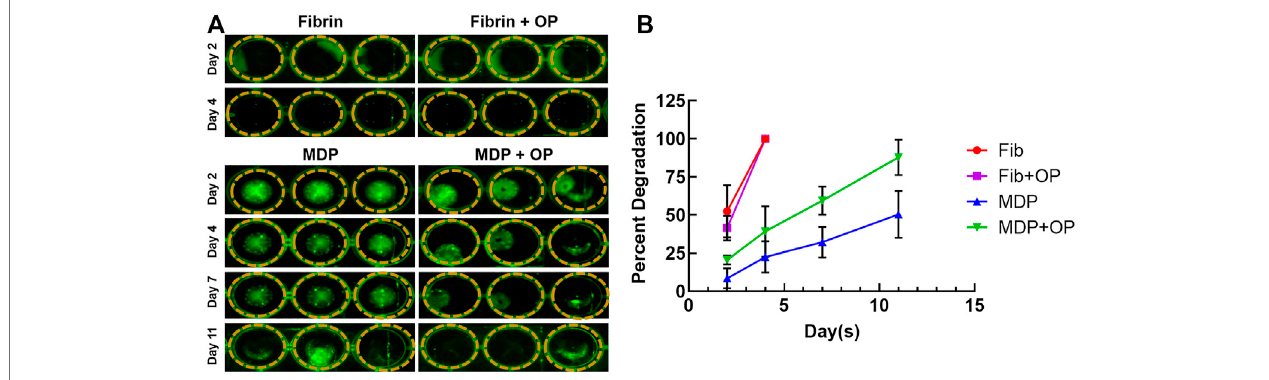
FIGURE 2 | In vitro degradation of MDP and fi brin gel with and without Oxo-M and 4-PPBP. Fluorescence-labeled fi brin and MDP with or without Oxo-M and 4- PPBP(OP)wereimaged (A) ,andtheintegralofsignalintensitieswerequanti fi ed (B) ( n =3pergroup).MDPdeliveredwithOxo-Mand4-PPBPenhancedtendonhealing in vivo .